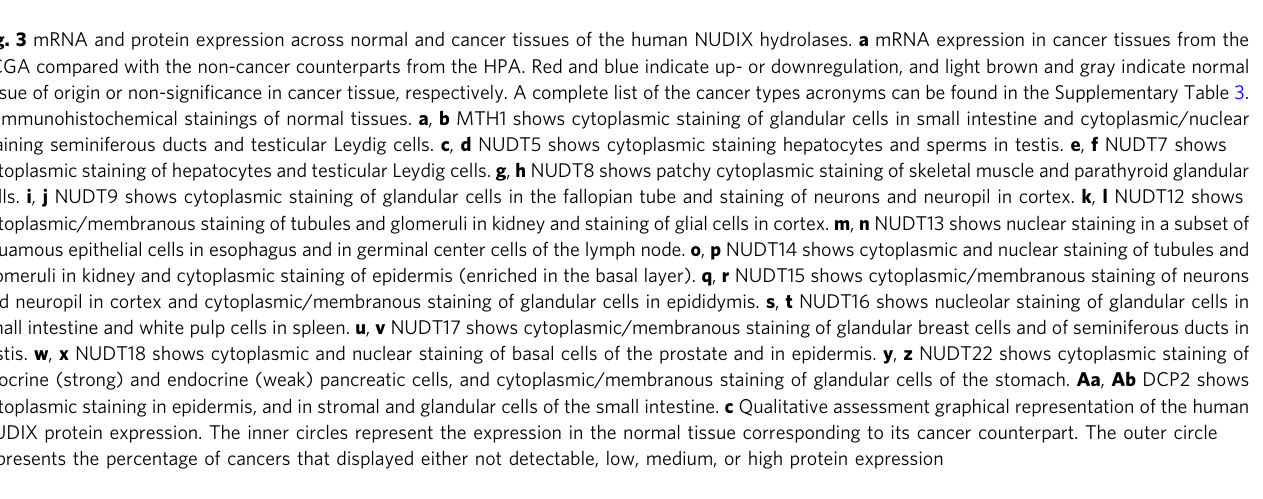
Fig. 3 mRNA and protein expression across normal and cancer tissues of the human NUDIX hydrolases. a mRNA expression in cancer tissues from the TCGA compared with the non-cancer counterparts from the HPA. Red and blue indicate up- or downregulation, and light brown and gray indicate normal tissue of origin or non-signi fi cance in cancer tissue, respectively. A complete list of the cancer types acronyms can be found in the Supplementary Table 3. b Immunohistochemical stainings of normal tissues. a , b MTH1 shows cytoplasmic staining of glandular cells in small intestine and cytoplasmic/nuclear staining seminiferous ducts and testicular Leydig cells. c , d NUDT5 shows cytoplasmic staining hepatocytes and sperms in testis. e , f NUDT7 shows cytoplasmic staining of hepatocytes and testicular Leydig cells. g , h NUDT8 shows patchy cytoplasmic staining of skeletal muscle and parathyroid glandular cells. i , j NUDT9 shows cytoplasmic staining of glandular cells in the fallopian tube and staining of neurons and neuropil in cortex. k , l NUDT12 shows cytoplasmic/membranous staining of tubules and glomeruli in kidney and staining of glial cells in cortex. m , n NUDT13 shows nuclear staining in a subset of squamous epithelial cells in esophagus and in germinal center cells of the lymph node. o , p NUDT14 shows cytoplasmic and nuclear staining of tubules and glomeruli in kidney and cytoplasmic staining of epidermis (enriched in the basal layer). q , r NUDT15 shows cytoplasmic/membranous staining of neurons and neuropil in cortex and cytoplasmic/membranous staining of glandular cells in epididymis. s , t NUDT16 shows nucleolar staining of glandular cells in small intestine and white pulp cells in spleen. u , v NUDT17 shows cytoplasmic/membranous staining of glandular breast cells and of seminiferous ducts in testis. w , x NUDT18 shows cytoplasmic and nuclear staining of basal cells of the prostate and in epidermis. y , z NUDT22 shows cytoplasmic staining of exocrine (strong) and endocrine (weak) pancreatic cells, and cytoplasmic/membranous staining of glandular cells of the stomach. Aa , Ab DCP2 shows cytoplasmic staining in epidermis, and in stromal and glandular cells of the small intestine. c Qualitative assessment graphical representation of the human NUDIX protein expression. The inner circles represent the expression in the normal tissue corresponding to its cancer counterpart. The outer circle represents the percentage of cancers that displayed either not detectable, low, medium, or high protein